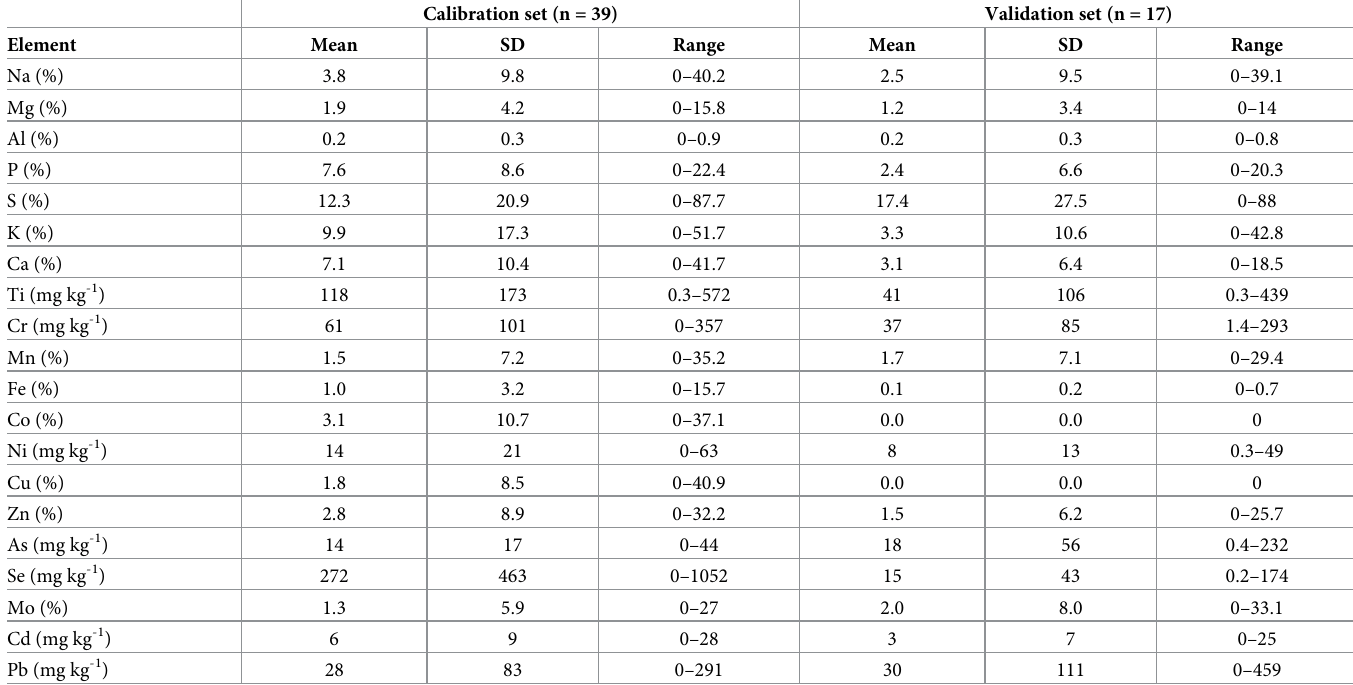
Table 2. Descriptive statistics of elements of interest in the fertiliser calibration